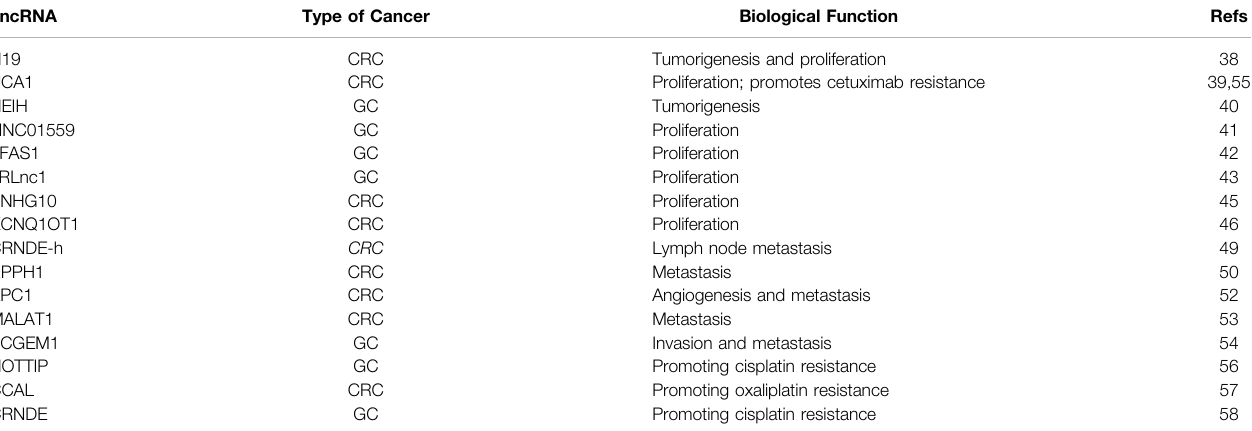
TABLE 1 | The function of exosomal lncRNAs in gastrointestinal